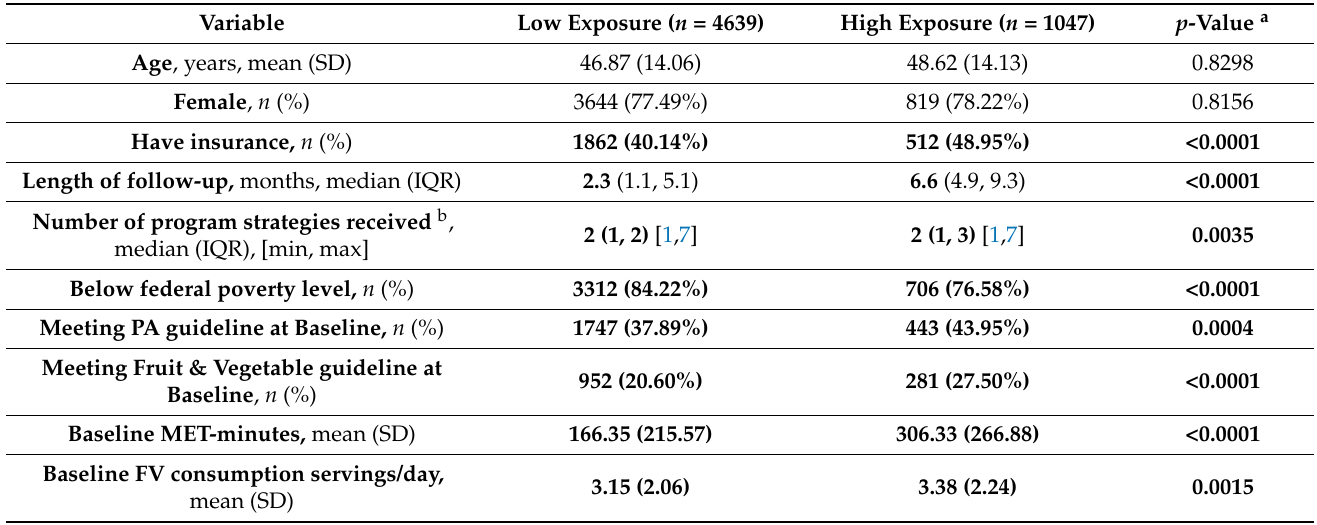
Table 2. Baseline characteristics of Latino participants enrolled in the TSSC Program ( n =